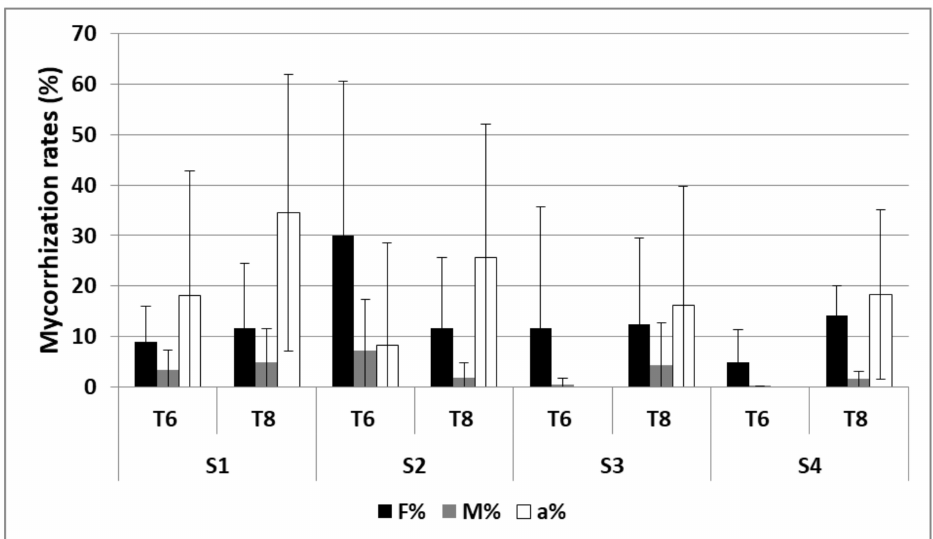
Figure 4. Mycorrhization rates (F%, M%, and a%) for plants at week 6 (T6) and week 8 (T8) after planting taking into account the different substrates used (S1: 100% coconut fiber; S2: 66% coconut fiber + 33% bagasse; S3: 50% coconut fiber + 50% bagasse; S4: 33% coconut fiber + 66% bagasse). F% (in black) corresponds to the percentage of roots with AMF structures; M% (in grey) corresponds to the percentage of colonization inside roots; a% (in white) corresponds to the content in arbuscules of mycorrhized parts.